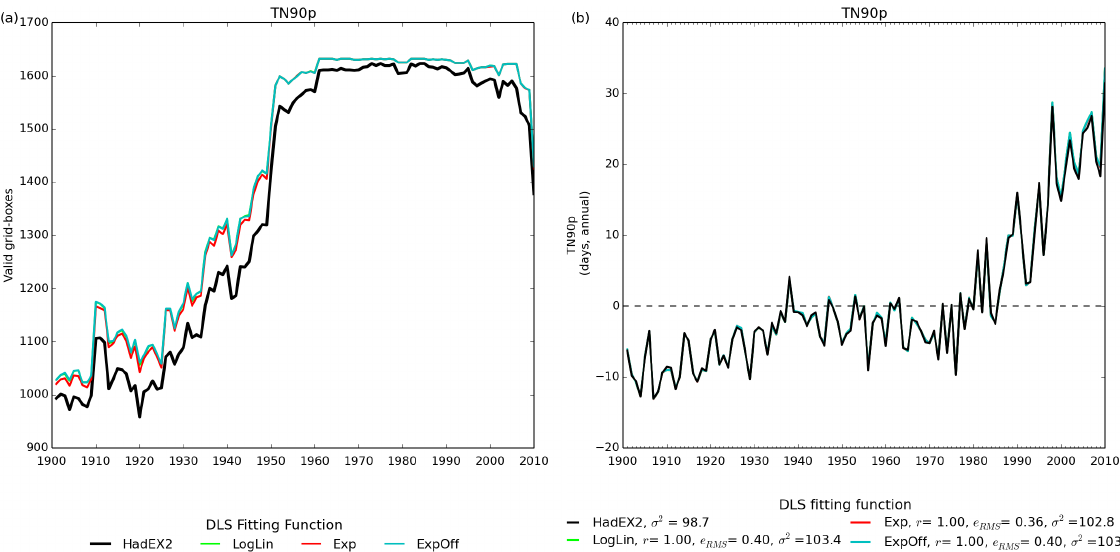
Figure 13. (a) The number of non-missing grid boxes and (b) the time series for global average TN90p for the different DLS calculation methods. Note that the global average only takes grid boxes which have 90% completeness or more, whereas all grid boxes are shown in the coverage series. All choices have been centred relative to the climatology period 1961–1990, reducing the spread during this time.